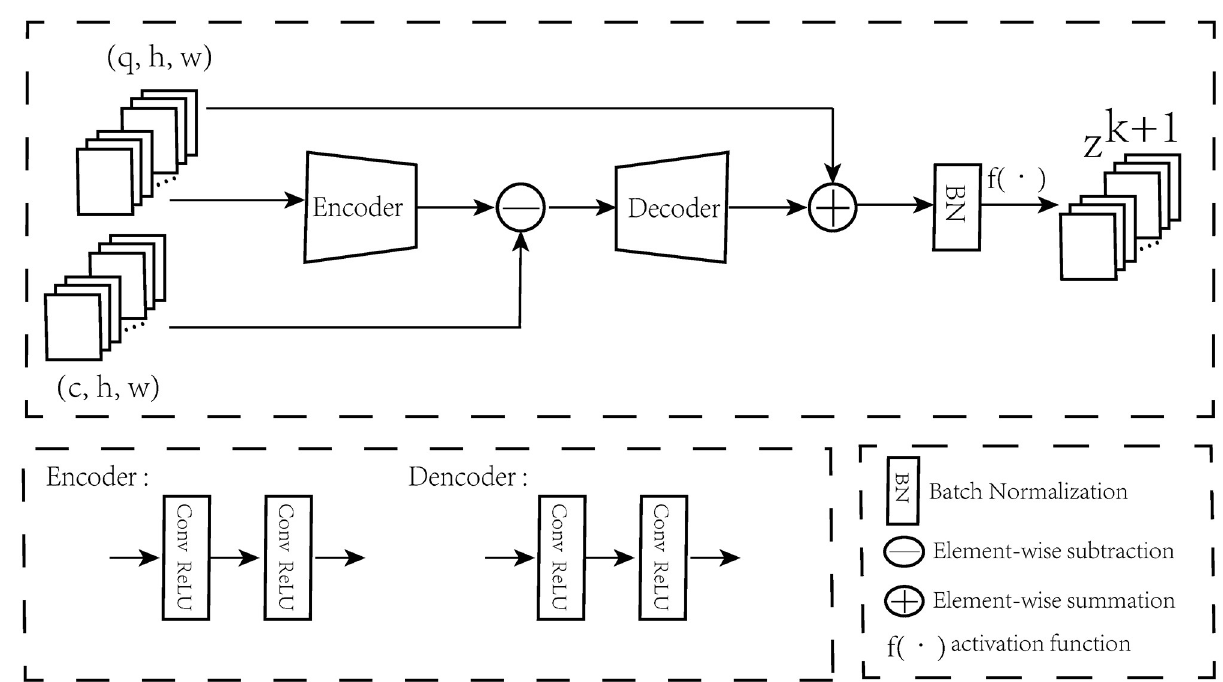
Fig 2. Architecture of DCU. It mainly contains encoder and decoder layers, and we can use different kernel sizes to achieve different scales of information.